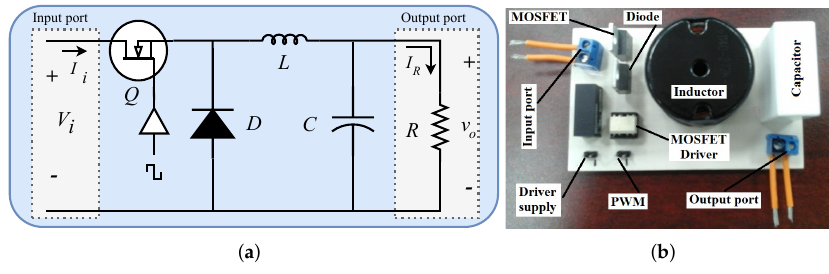
Figure 1. Buck converter. ( a ) Electrical diagram. ( b ) Electrical implementation. Table 1. Parameter values for the implementation of buck converter in Figure